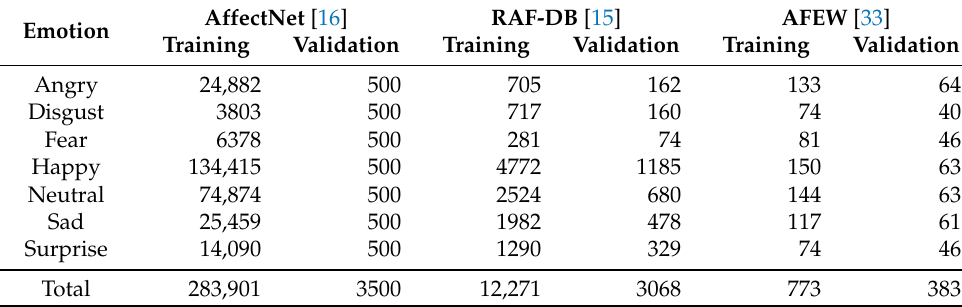
Table 1. Image and video emotion recognition